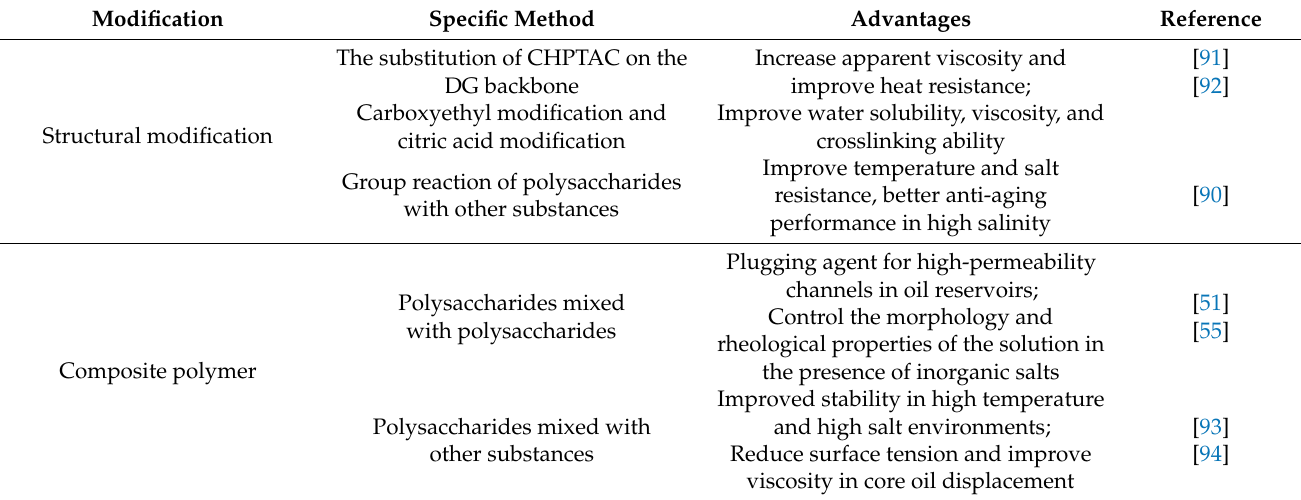
Table 3. Structural transformation methods and their